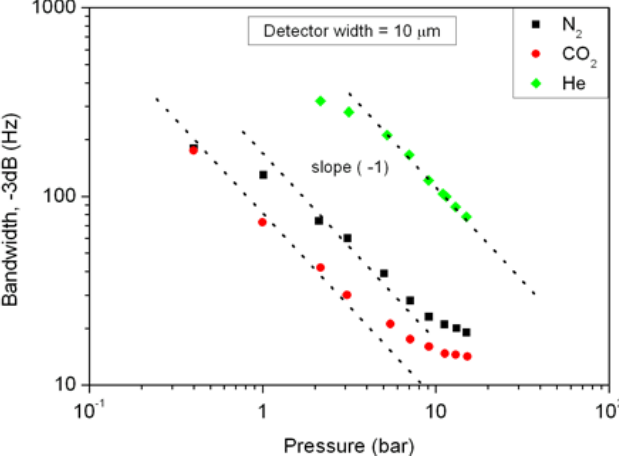
Figure 10. Experimental results of the sensor bandwidth at −3 dB vs. gas pressure.